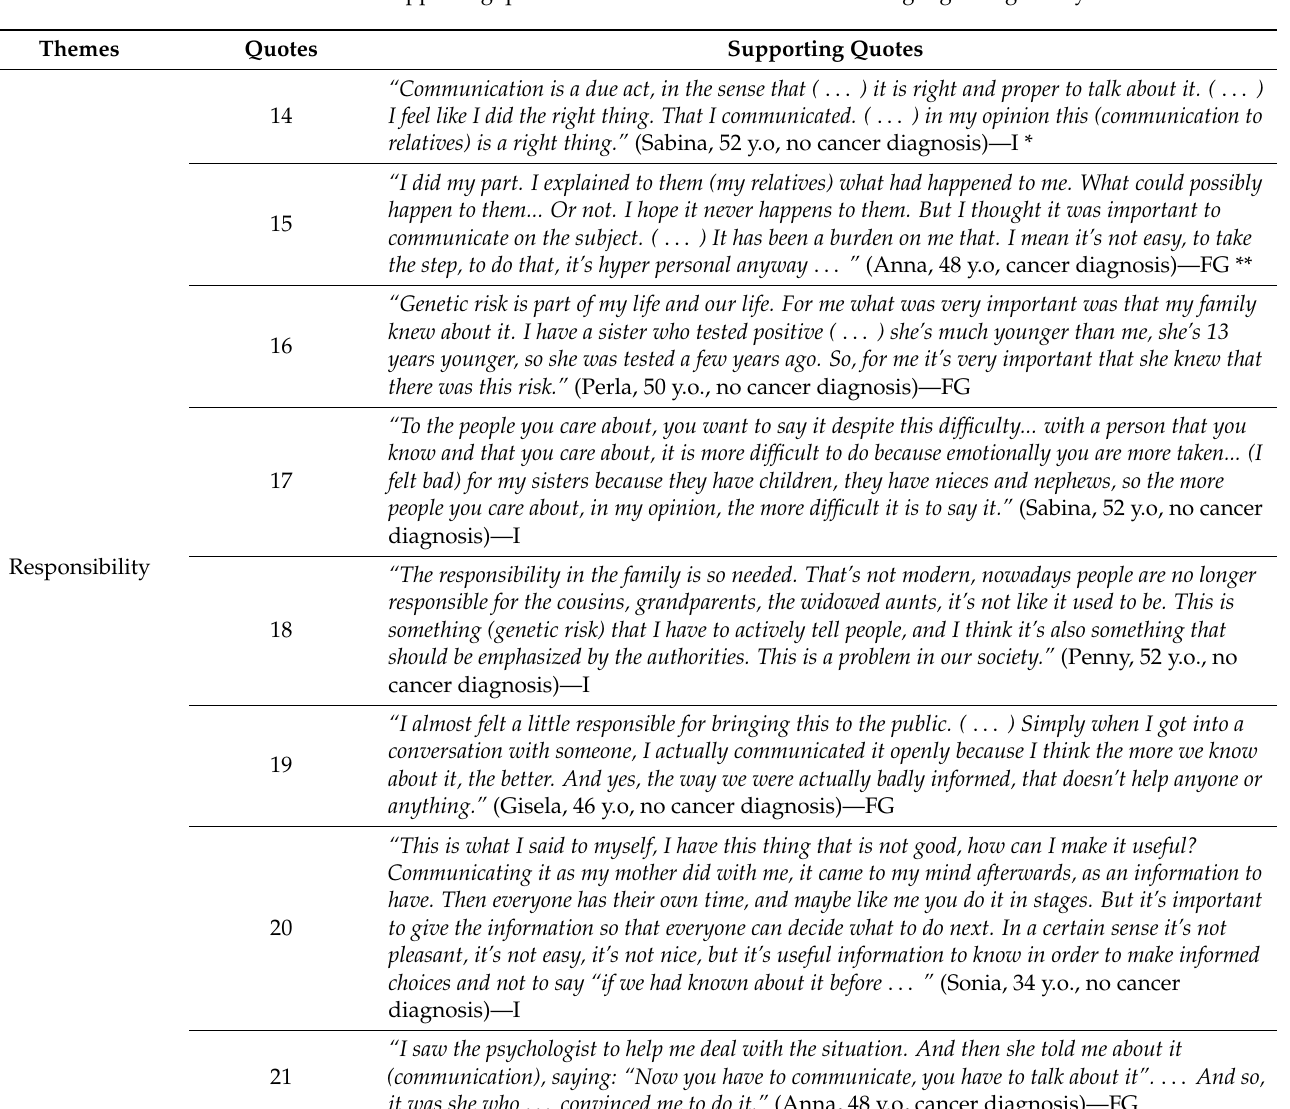
Table 3. Supporting quotes about “Probands’ decision-making regarding family